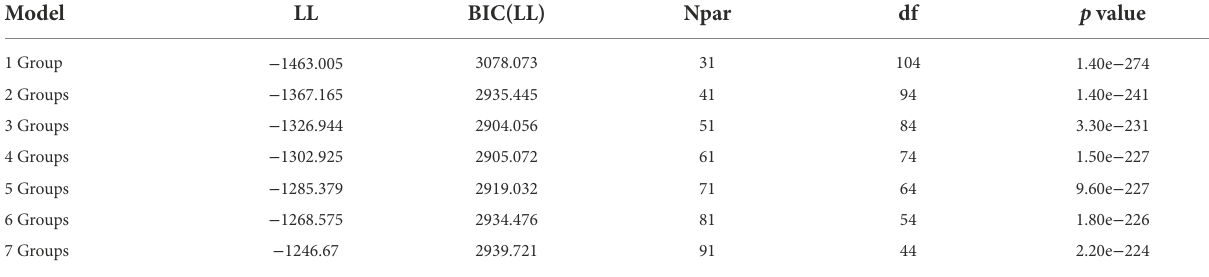
TABLE 2 Goodness-of-Fit statistics for Latent Class Factor Analysis (LCFA) Models on Writing Flow State Scale (WFSS; n = 135).